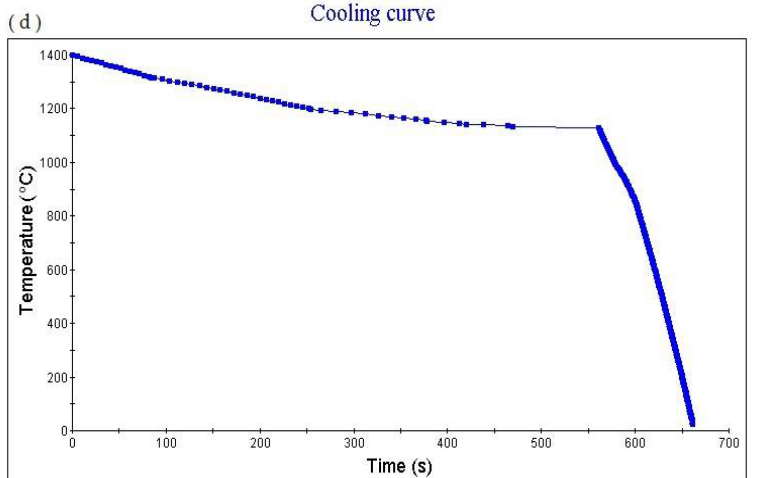
Figure 4. Solidification physical properties. Physical properties for Fe 25 Cr 25 Ni 25 Ti 12.5 Al 12.5 multi- principle element alloys. ( a ) general physical properties (fraction solid–temperature); ( b ) general physical properties (fraction liquid–temperature); ( c ) wt.% element in liquid–temperature; ( d ) cooling curve (temperature–time).